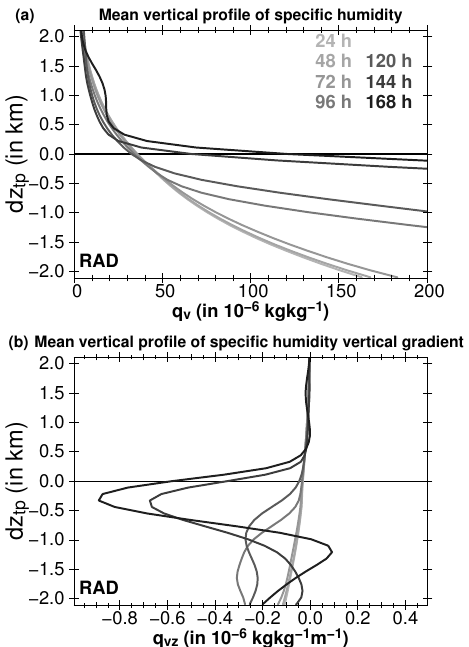
Figure 4. Instantaneous thermal tropopause-based domain mean values of (a) specific humidity q v (in 10 − 6 kgkg − 1 ) and (b) the ver- tical gradient of specific humidity ∂q v /∂z (in 10 − 6 kgkg − 1 m − 1 ) for RAD. The domain mean is calculated within 25–65 ◦ latitude and the entire zonal domain. d z tp is the distance to the height of the thermal tropopause. The intensity of the gray colors indicates the time since model start in 24h intervals.